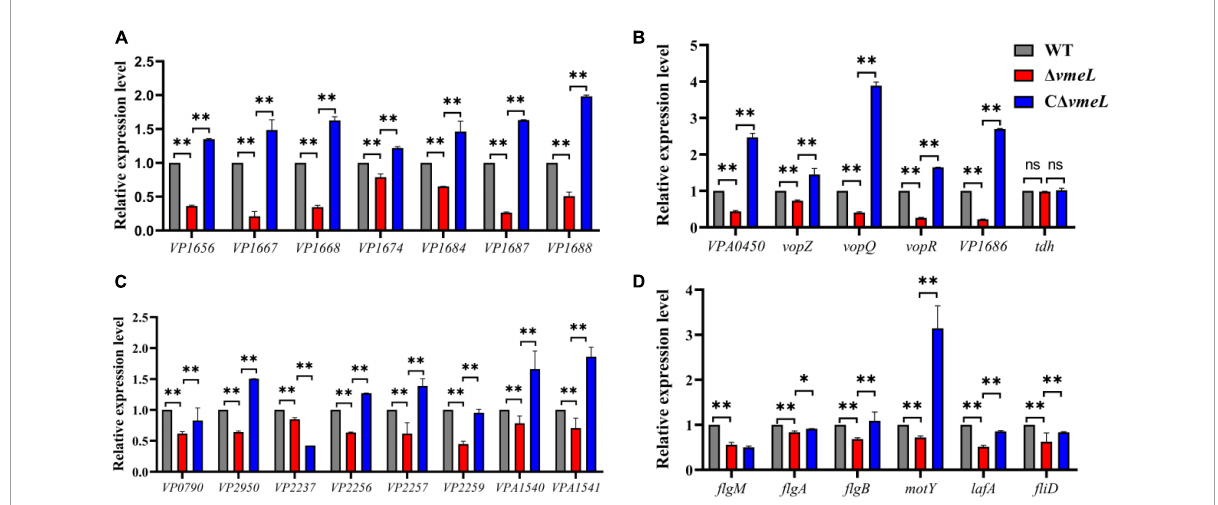
FIGURE7 Quantitative reverse transcription-PCR verification of target genes in strains WT, (cid:49) vmeL , C (cid:49) vmeL . The transcriptional levels of (A) T3SS1 structural genes, (B) T3SS1 effector genes and (C) flagellar-related genes were tested using the templates that collected from strains incubated in liquid medium. (D) The first gene of every operon was chosen to verify the transcriptional levels of lateral flagella genes in (cid:49) vmeL as compared to those in the wild type (WT), and the templates that collected from strains incubated on swarming plates. WT, wild-type; (cid:49) vmeL , vmeL deletion mutant; C (cid:49) vmeL , deletion mutant complemented strain. ** indicates statistical significance at P < 0.01. ns, no significant